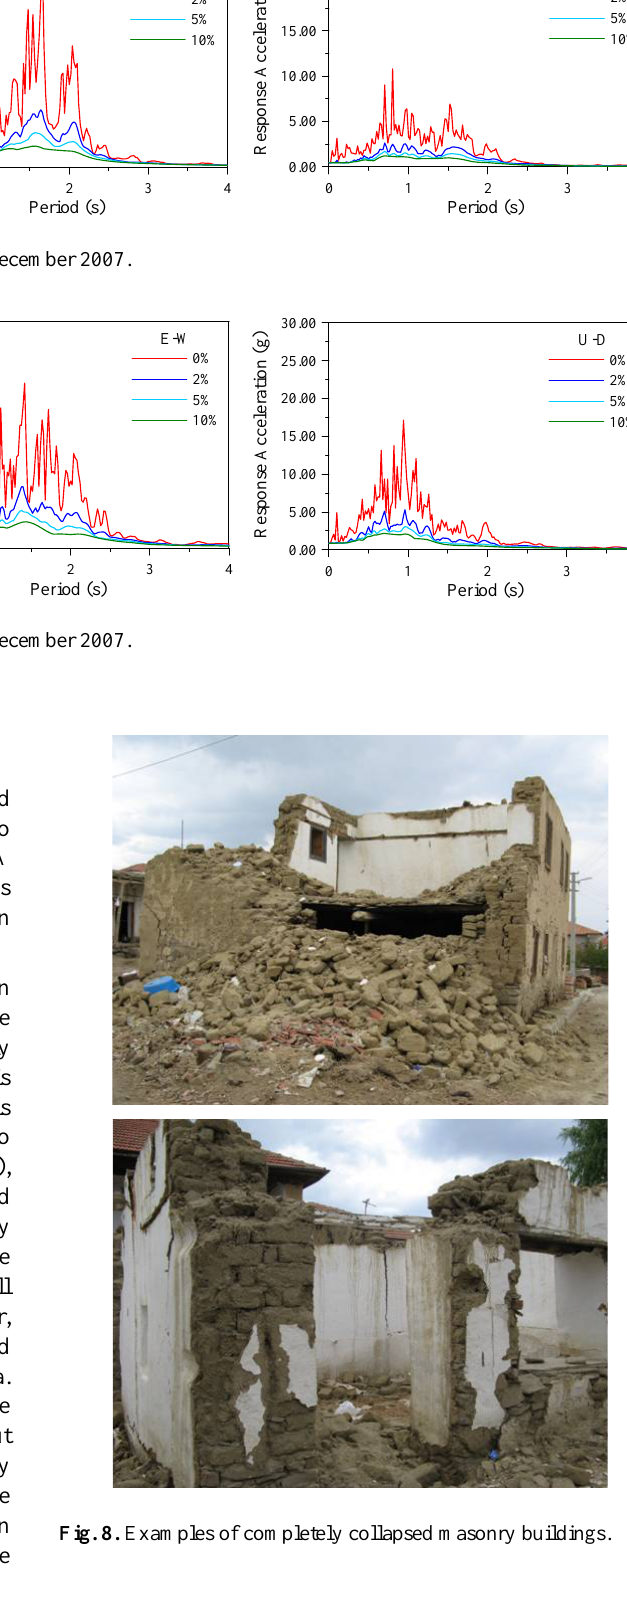
Fig. 8. Examples of completely collapsed masonry Fig. 8 Examples of completely collapsed masonry buildings